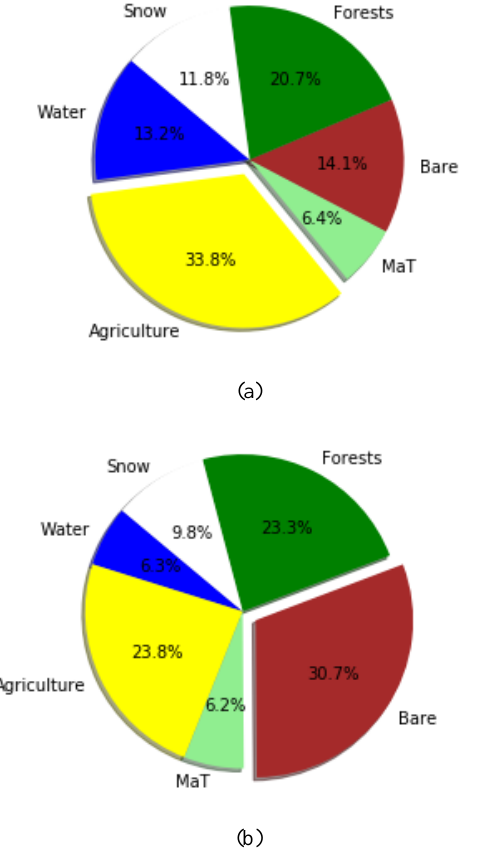
Figure 4. LULC percentage of the class change between (a) 1999 and (b) 2019. The highest percentage is highlighted.